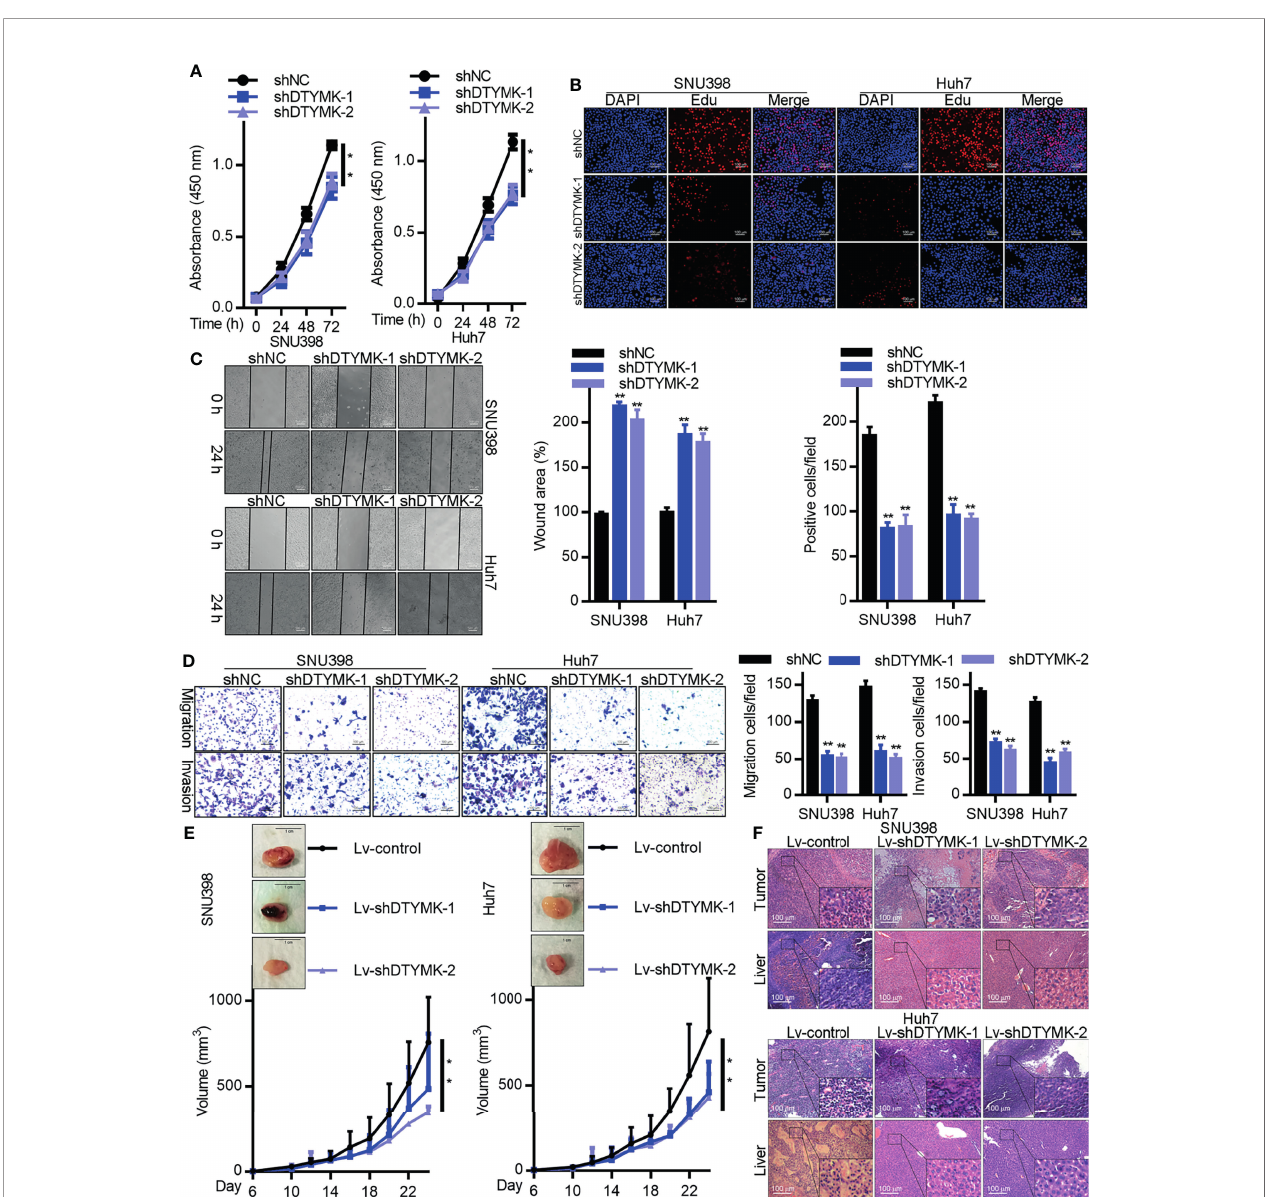
FIGURE 2 | DTYMK promotes HCC tumorigenesis. (A) The proliferation of SNU398 (left) and Huh7 (right) cells in which DTYMK was knocked down was assessed via CCK-8 assay and (B) EdU incorporation staining assay. Scale bars 100 m m. (C) A wound healing assay was used to assess the migration of cells treated as in (A) . Scale bar, 500 m m. (D) The migratory and invasive activity of cells treated as in (A) was assessed via Transwell assay. Scale bar, 100 m m. (E) The impact of DTYMK knockdown on the growth of SNU398 (left) and Huh7 (right) tumors. Tumor volume was measured every other day, and animals were euthanized 24 days post-implantation, at which time tumors were excised. n=6 mice/group. Scale bar, 1 cm. (F) H&E staining analysis of the tumor and liver section in mice xenografts. Scale bars, 100 m m. Data are means ± SD. * p < 0.05; ** p < 0.01; Student ’ s